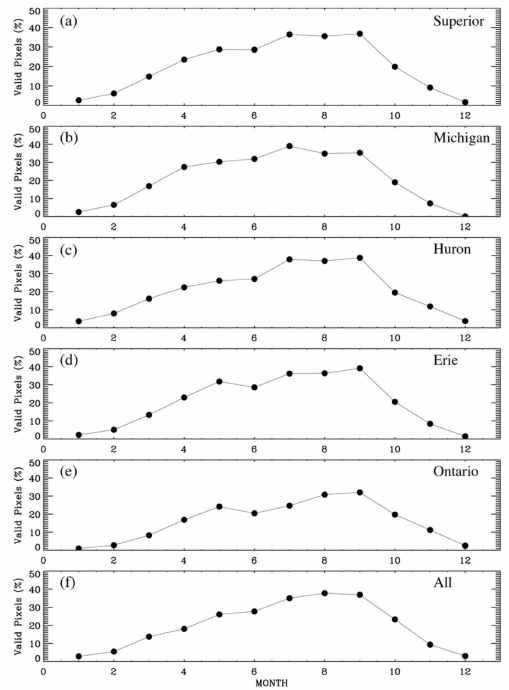
Figure 8. Mean valid pixels of daily VIIRS–SNPP-derived ocean color data in each month for ( a ) Lake Superior, ( b ) Lake Michigan, ( c ) Lake Huron, ( d ) Lake Erie, ( e ) Lake Ontario, and ( f ) all